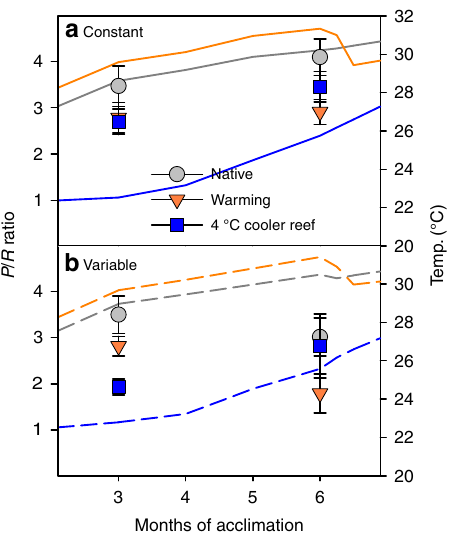
Fig. 4 Photosynthesis-to-respiration ratio ( P / R ) after 3 and 6 months of acclimation. Acropora aspera corals were maintained under a constant daily temperatures or b 4 °C daily temperature variability. Solid and dashed lines represent monthly tank temperatures for each treatment (Table S2). Mean ± 1 S.E.M. is shown. Source data are provided as a Source Data fi